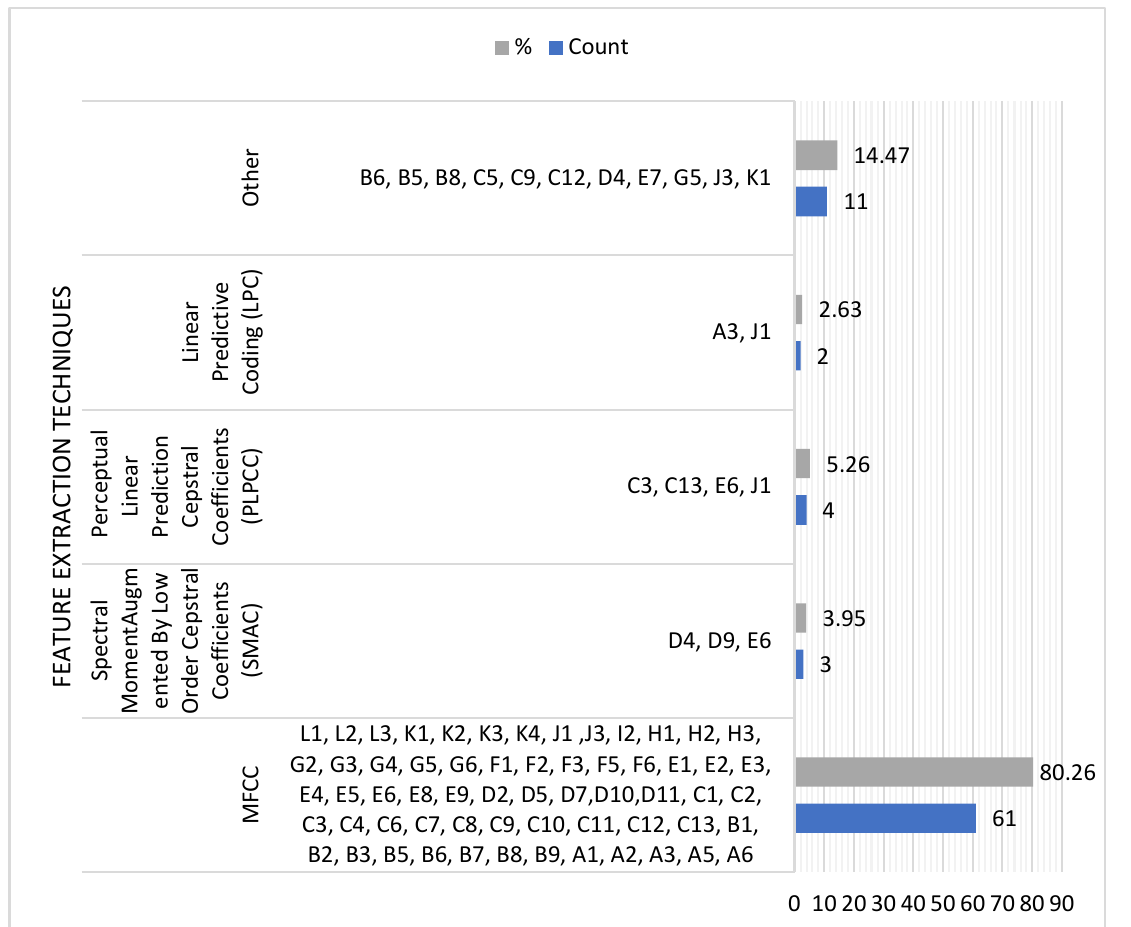
Figure 5. Techniques used to extract the acoustic features.